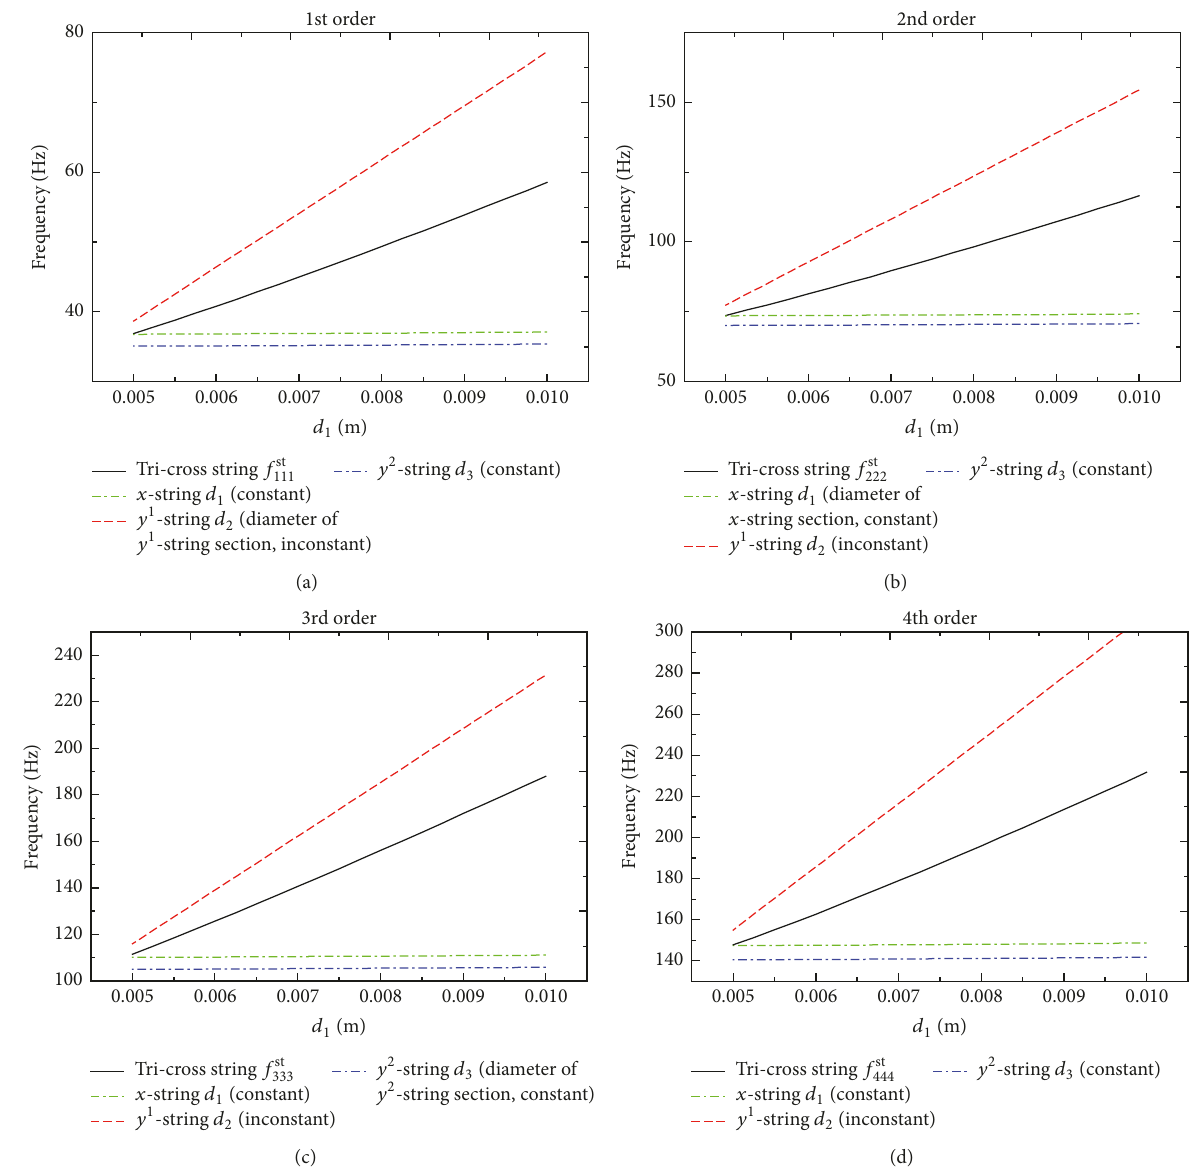
Figure 5: The influence of the diameter of one constituent string on the first four frequencies of the strings: (a) the first mode 𝑓 st 111 , (b) the second mode 𝑓 st 222 , (c) the third mode 𝑓 st 333 , and (d) the fourth mode 𝑓 st 444